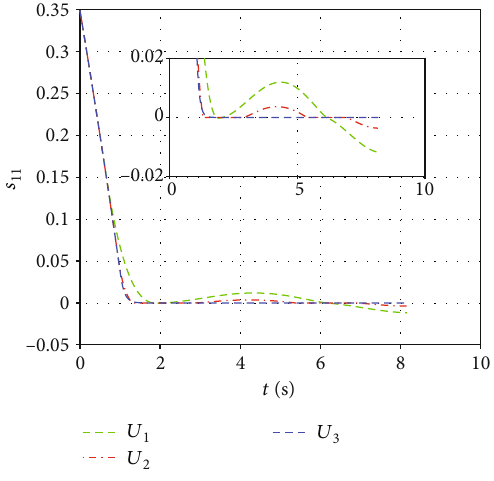
Figure 43: Dynamic error surfaces s